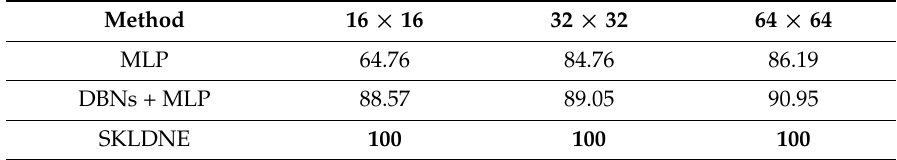
Table 8. Maximum recognition accuracies (in percentage terms) of SKLDNE and other methods on the JAFFE